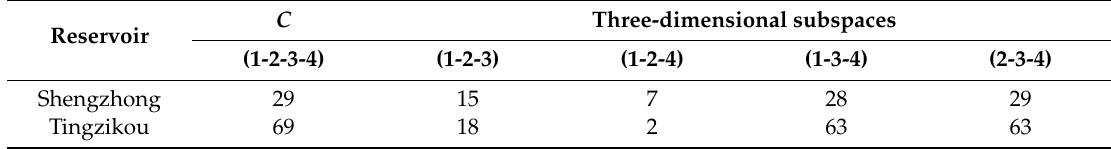
Table 5. Number of Pareto-optimal alternatives in all possible three-dimensional subspaces of C . C Three-dimensional Reservoir